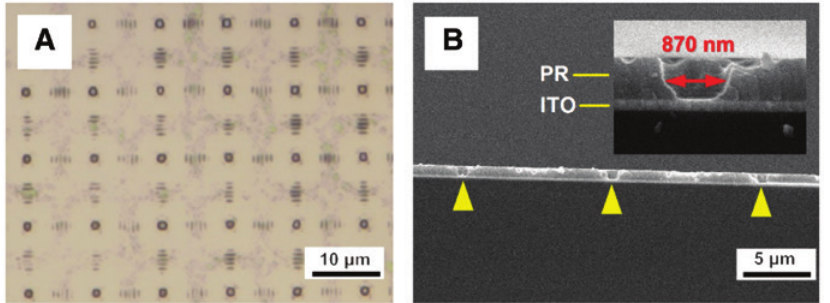
Figure 3: Microscopic characterization of the nanohole grating. (A) Optical microscope image and (B) SEM image of the cross-sectional profile of the 2D nanohole grating.